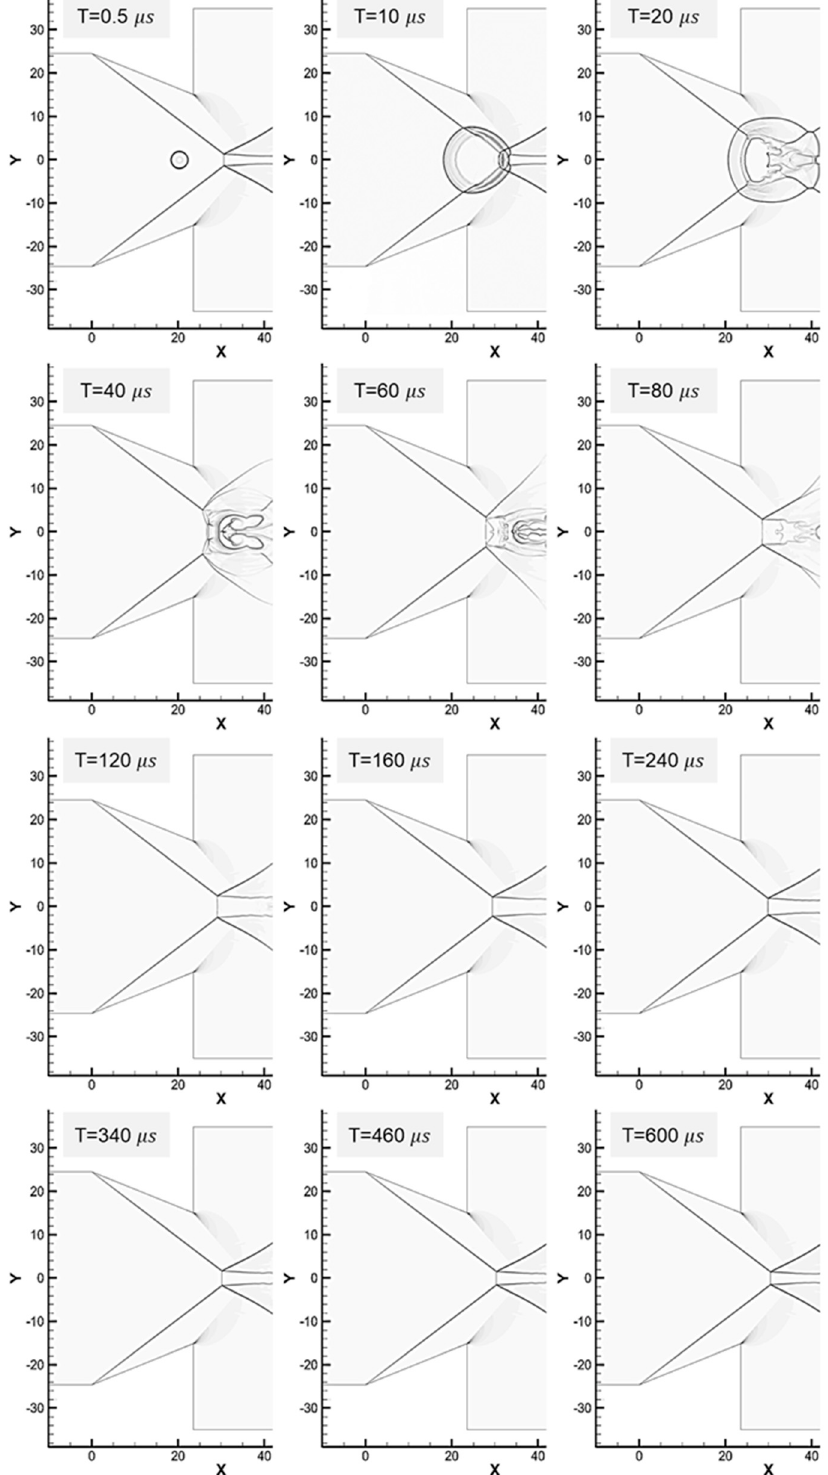
Figure 15. Interaction between blast wave and oblique shock, deposition downstream of the wedges. Energy: 107.5 mJ.